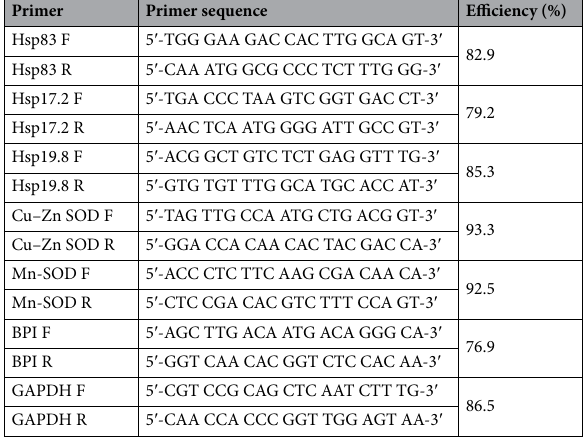
Table 1. Primer sequences and PCR efficiency for the genes used in this study.